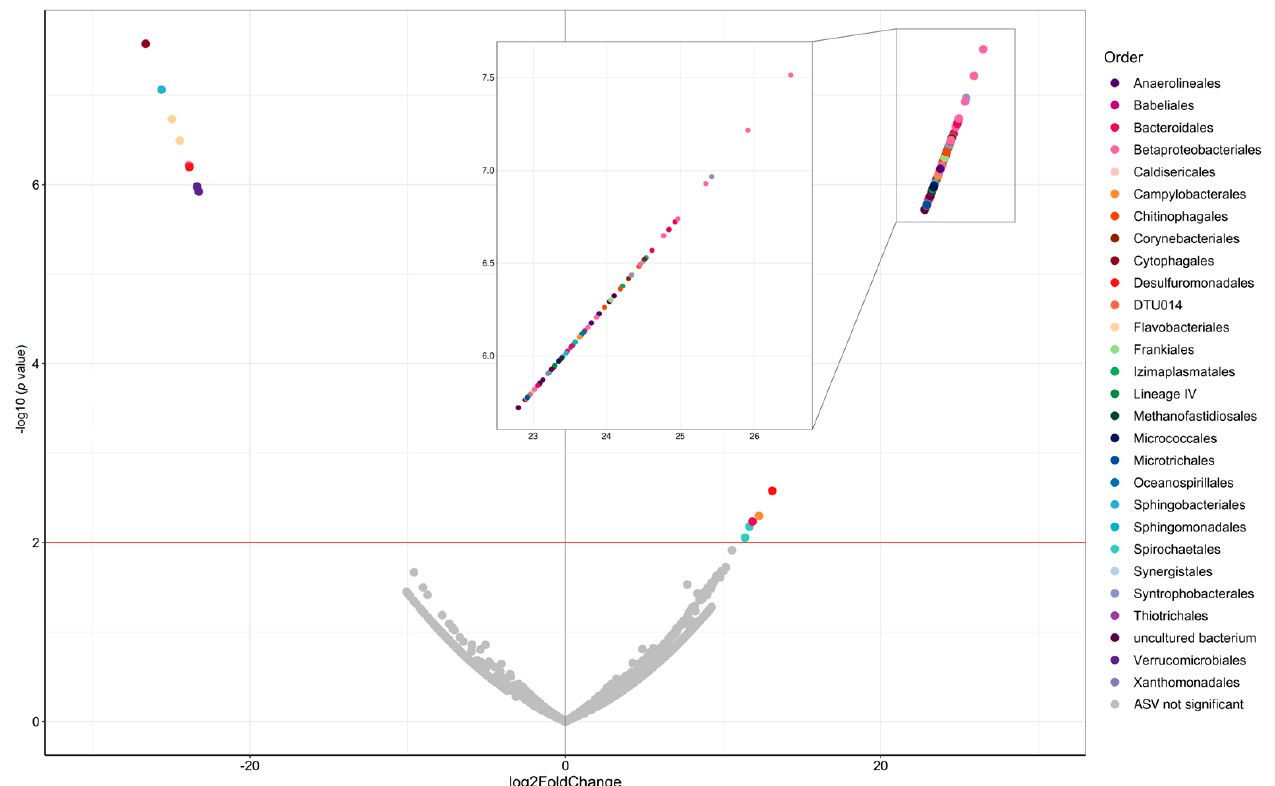
Figure 9. Volcano plot of differentially abundant ASVs identified between discharge and pre-discharge. A positive log2-fold change in relative abundance indicates the feature predominated in discharge water, and vice versa for pre-discharge water. The gray dots denote the ASVs without marked differences ( p -value > 0.01, red line).